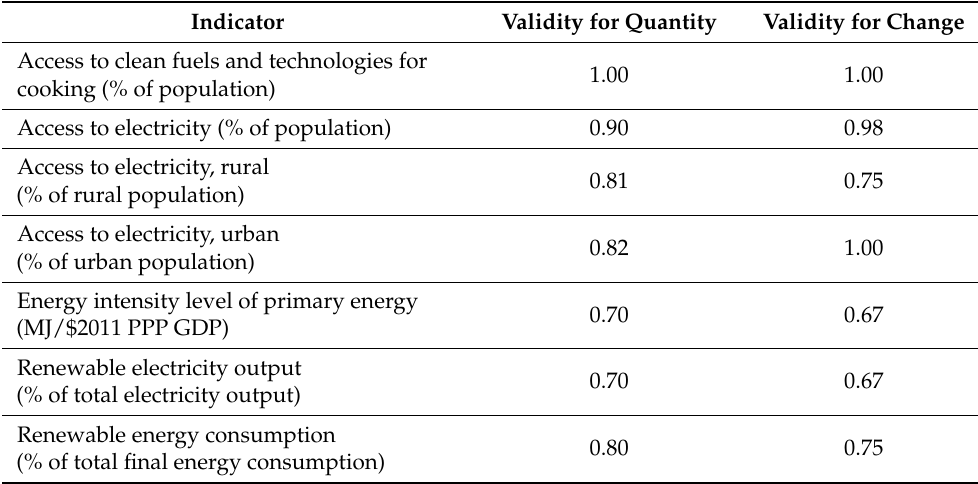
Table 3. The significance of individual indicators in the group classification in relation to the value of the indicators and the magnitude of their year-on-year change from 2000 to